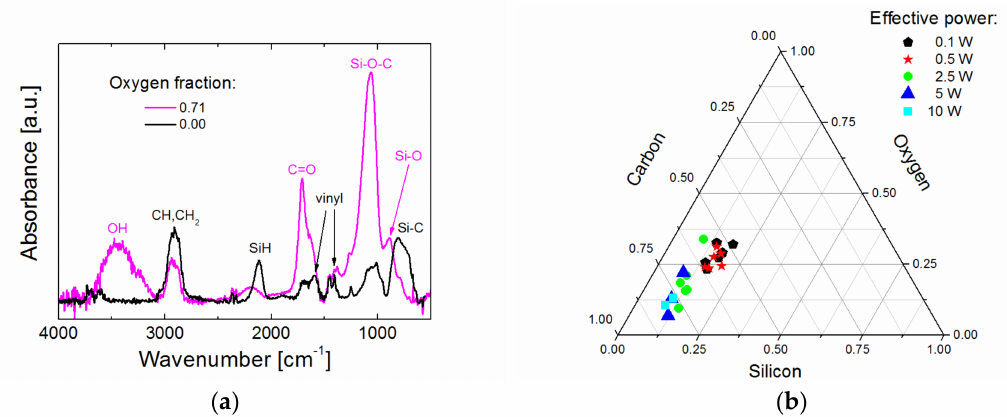
Figure 2. Chemical analysis of thin films: ( a ) infrared spectra for films deposited from pure TVS monomer and TVS/O 2 mixture at an oxygen fraction of 0.71 and 2.5 W; ( b ) ternary diagram of elemental composition for films deposited at different effective